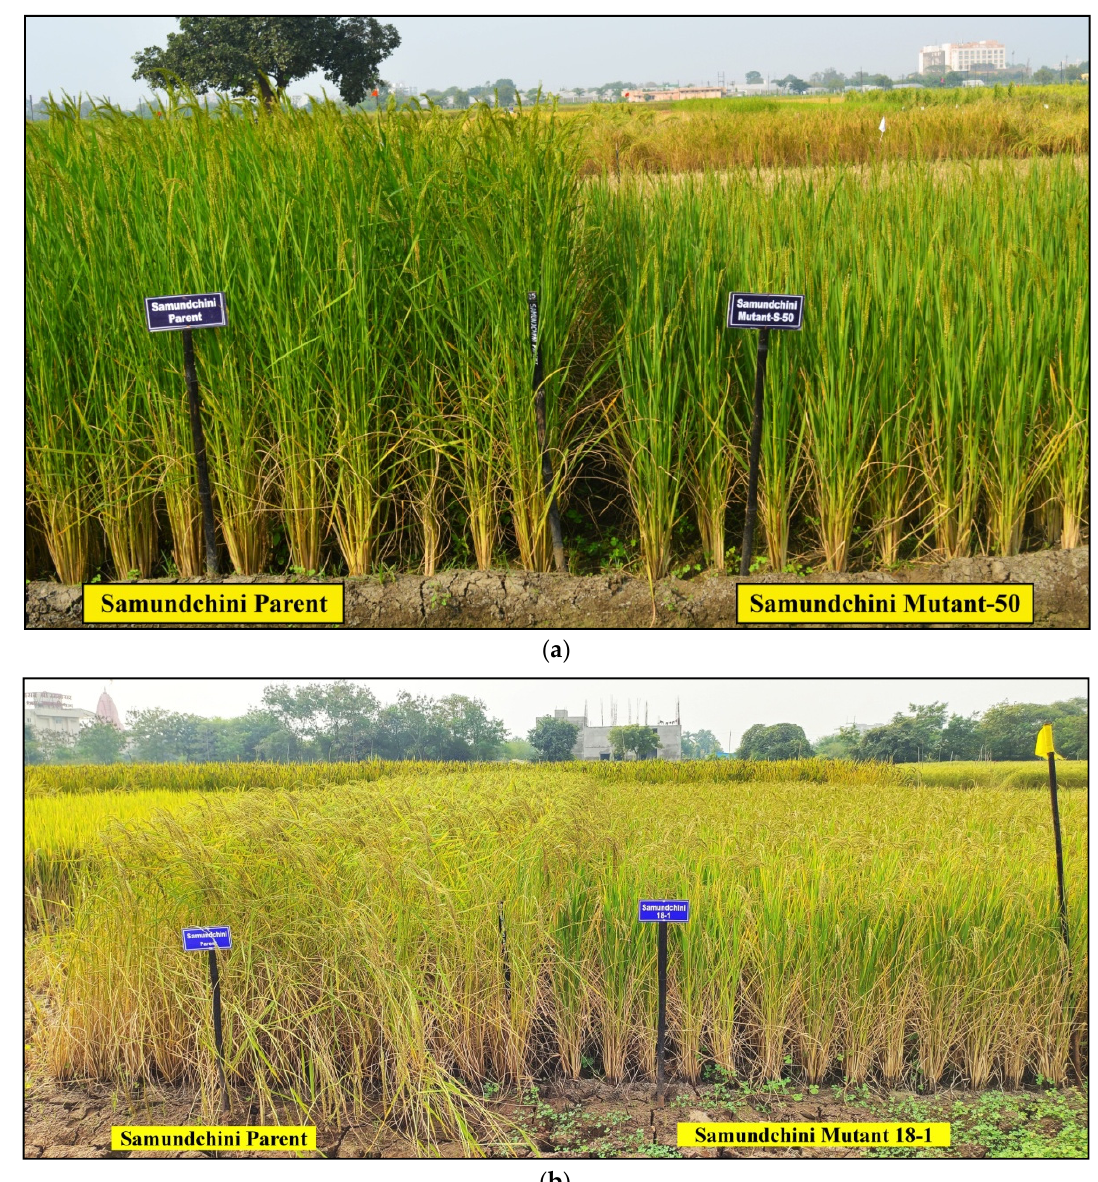
Figure 4. Comparative view of ( a ) Samundchini mutants, ( b ) Vishnubhog mutants and ( c ) Jhilli mu- tants with their corresponding parent.